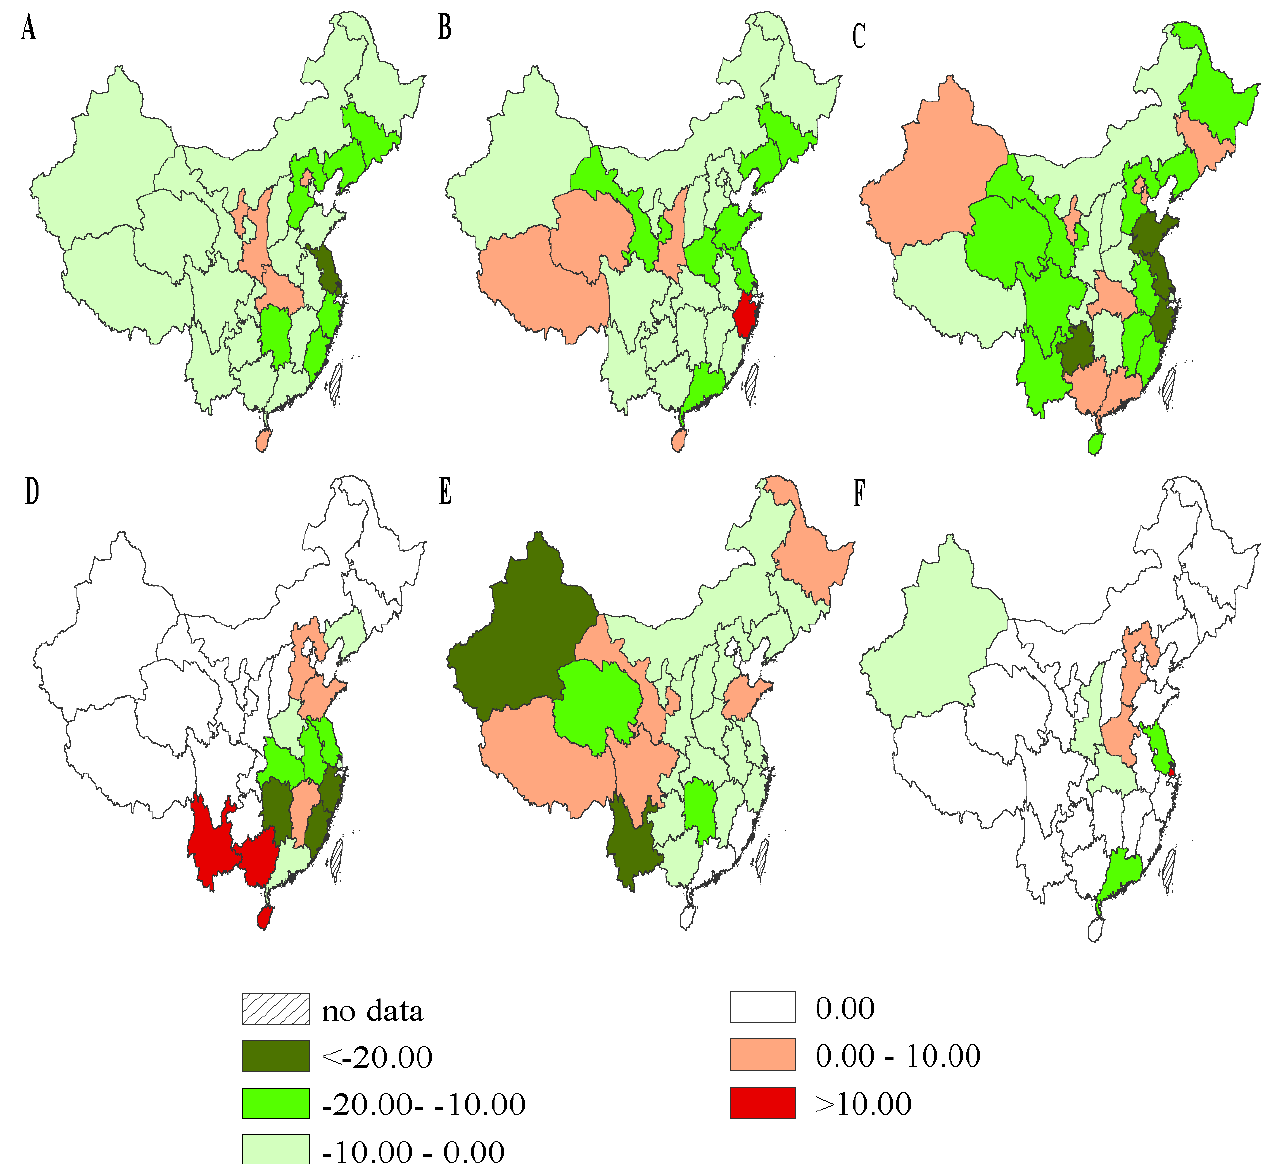
Figure 5. APC (%) of mortality caused by meteorological disasters at provincial level, 2004 – 2015: ( A ). All. ( B ). Floods. ( C ). Hail. ( D ). Typhoon. ( E ). Snow. ( F ). Heatwave. Note. ArcGIS 10.2